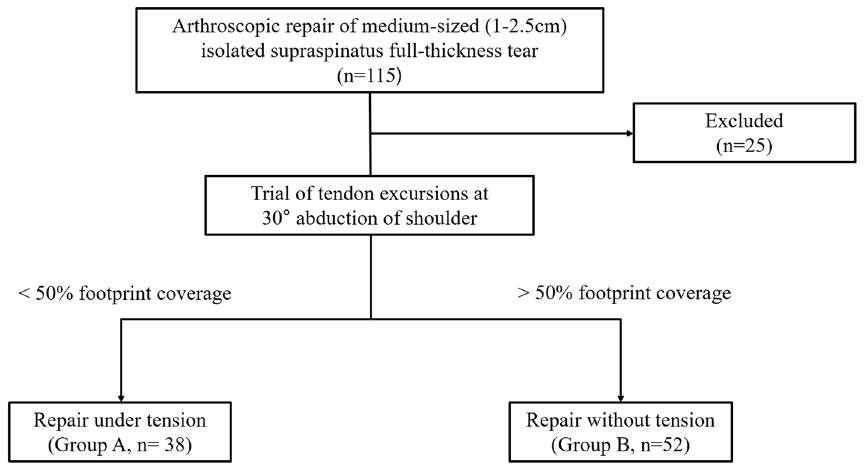
Figure 1. Diagram shows group assignment of this